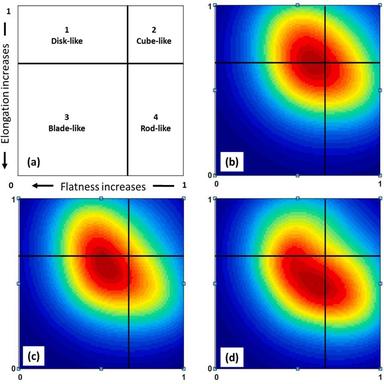
(a) Zingg's shape classification diagram with 4 zones. (b), (c) and (d) are the Zingg's diagrams for the particles from 3 selected size fractions, 0.05–0.1 mm, 0.3–0.6 mm and 0.6–1 mm, respectively. Warmer colors mean higher data density.